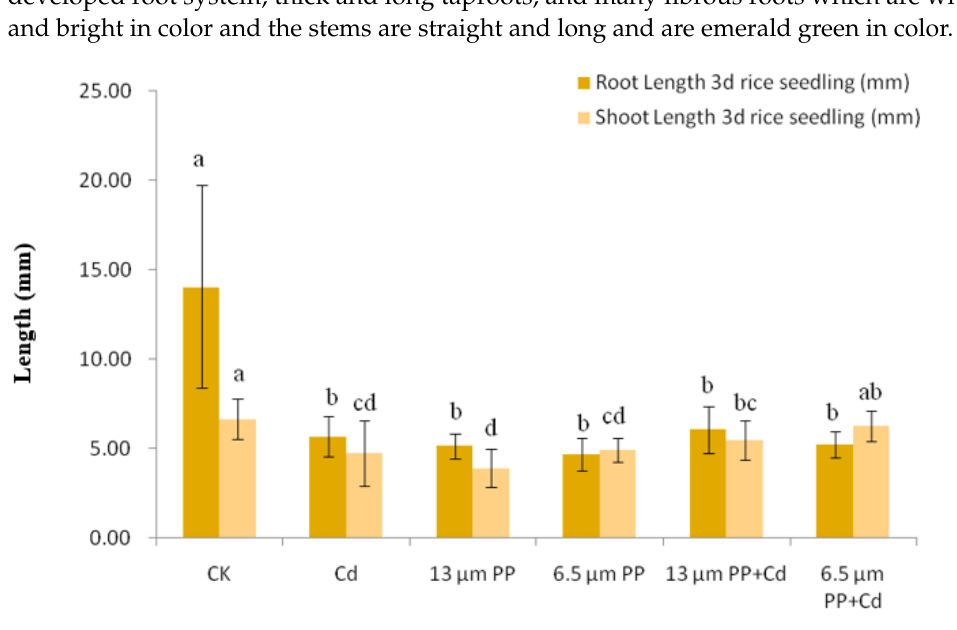
Figure 1. Effect of single and combined treatment of PP-MP and Cd on root and stem length of 3d rice seedlings. Results are shown in mean ±SD ( n = 9). Different letters a, b, c, d represent a significant difference between different treatments groups at the same MP particle size or at the same cadmium concentration (at p ≤ 0.05), whereas the same letters indicate insignificant differences between treatments. Where CK—Control check; Cd—Cadmium; PP—Polypropylene.